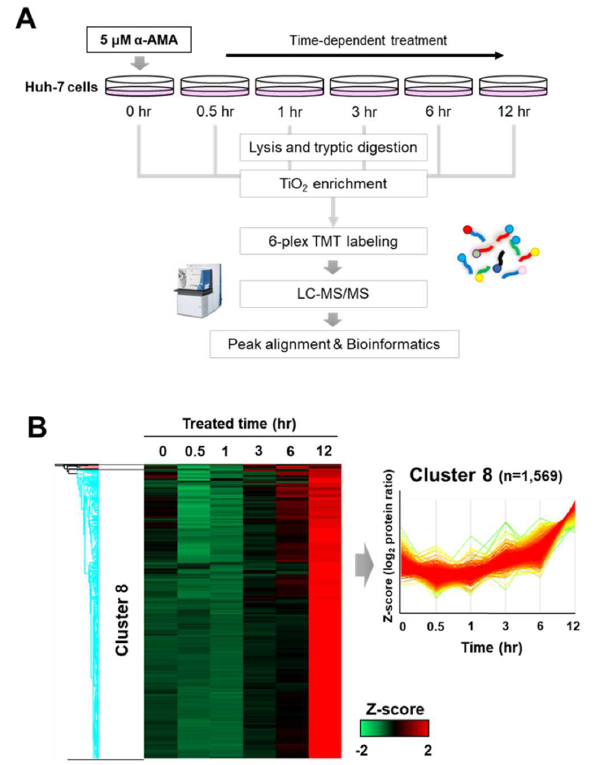
Figure 1. Systematic time profiling of the global phosphoproteome after α-amanitin (α-AMA) treatment of Huh-7 cells . ( A ) Schematic workflow of comparative phosphoproteome after treatment with α-AMA (5 μM) for 12 h. ( B ) Time-dependent unsupervised hierarchical clusters of phosphorylation after treating Huh-7 cells with α-AMA. Heatmap between each time point for the α-AMA treatment group after Z-score normalization.